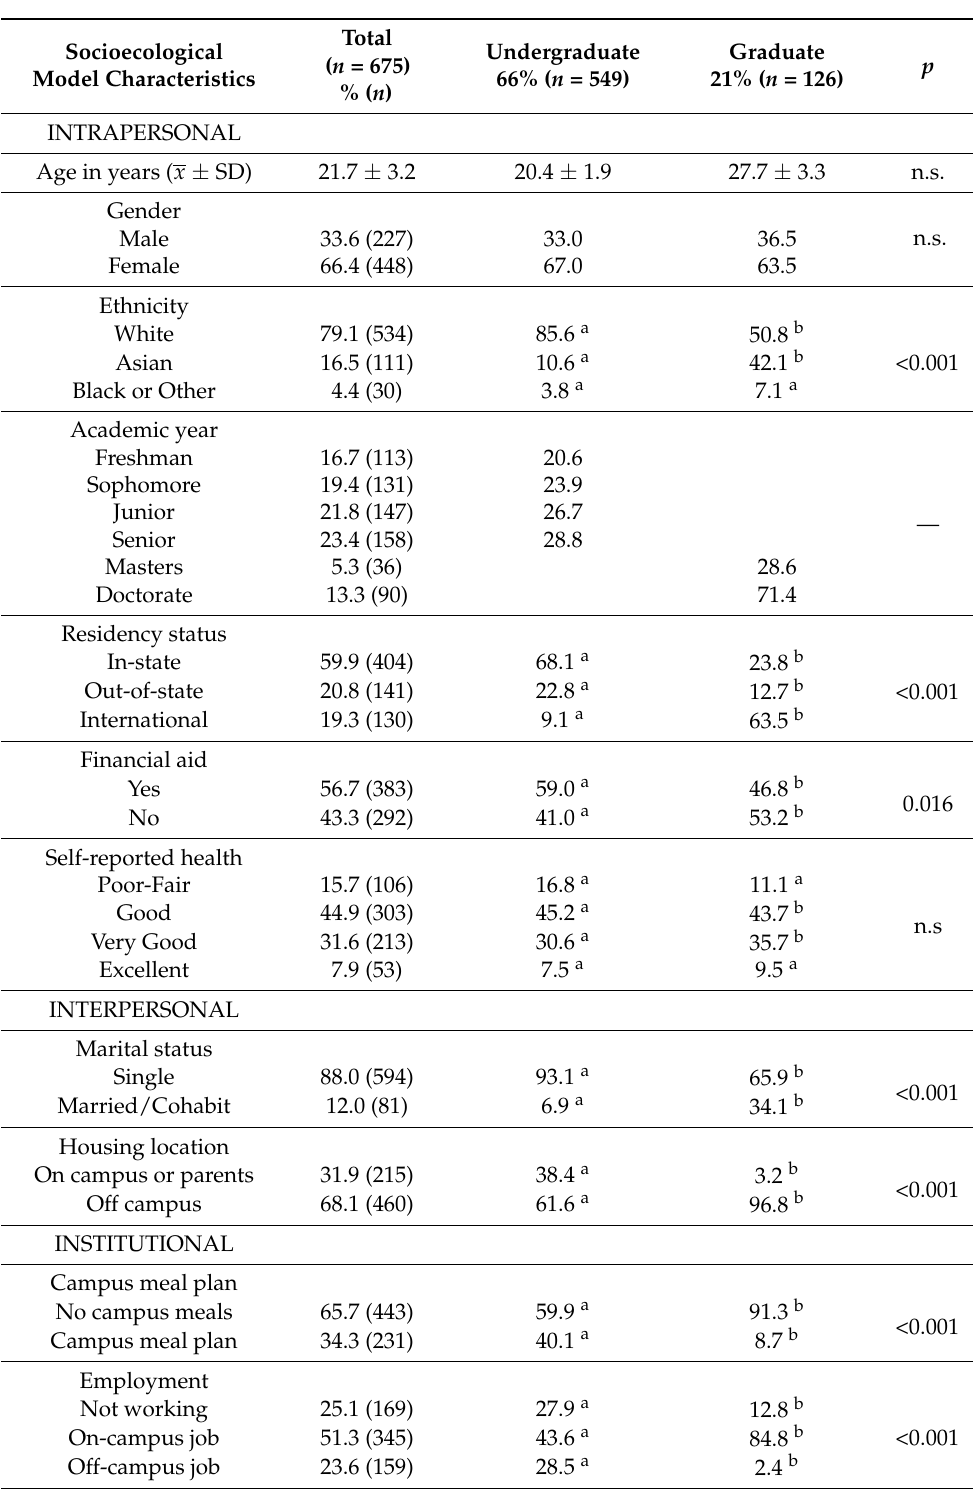
Table 1. Demographic characteristics of midwest university students by academic status 1